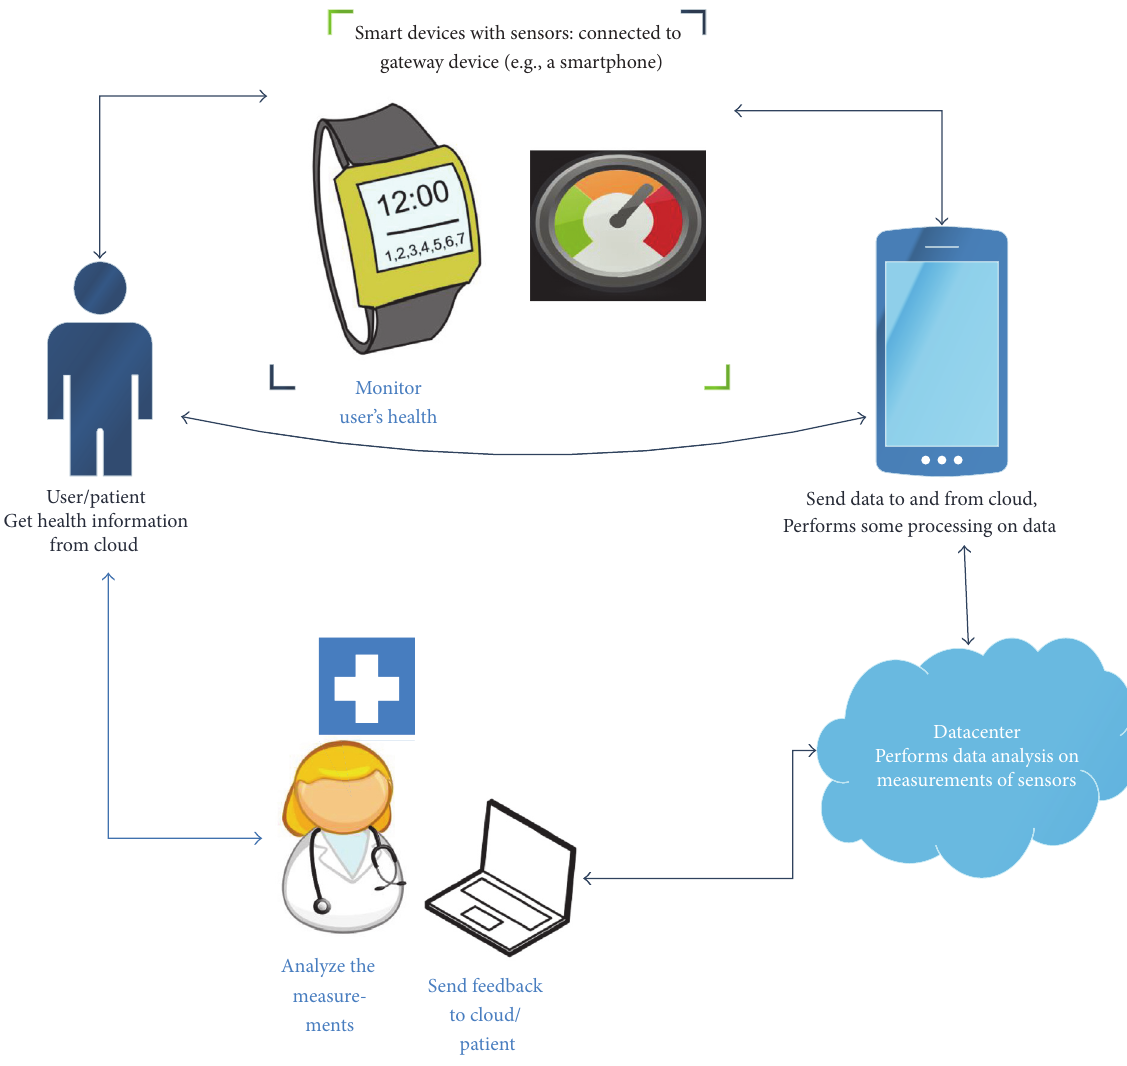
Figure 10: Block diagram of a smart healthcare